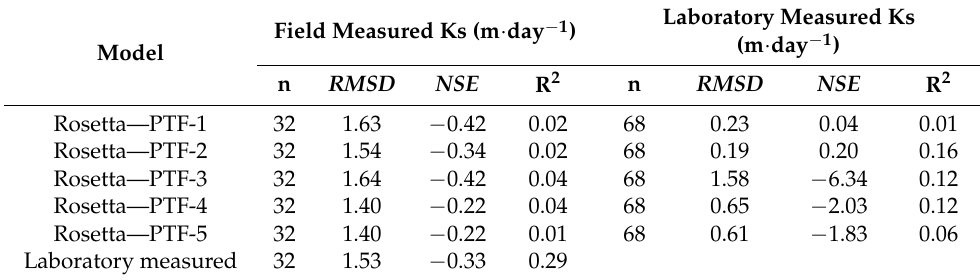
Table 8. Statistical indices for estimation of saturated hydraulic conductivity